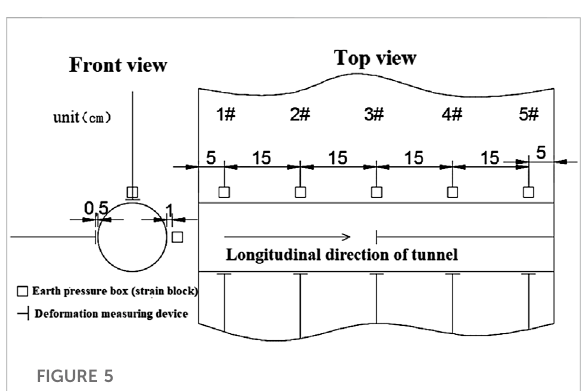
FIGURE 5 Monitoring section and monitoring device